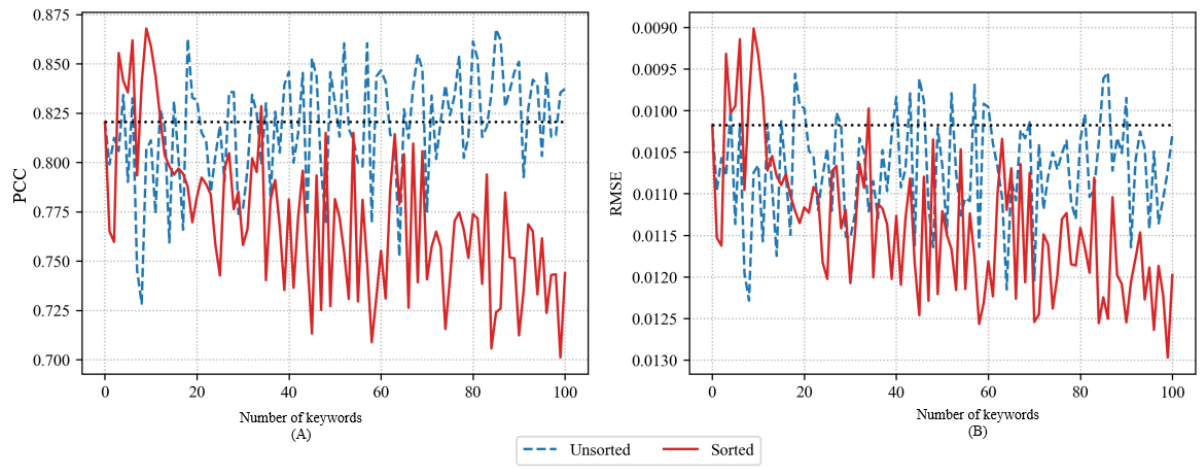
Figure 6. Pearson correlation coefficient (PCC) (A) and root-mean-square error (RMSE) (B) of long short-term memory models using FastText skip-gram.